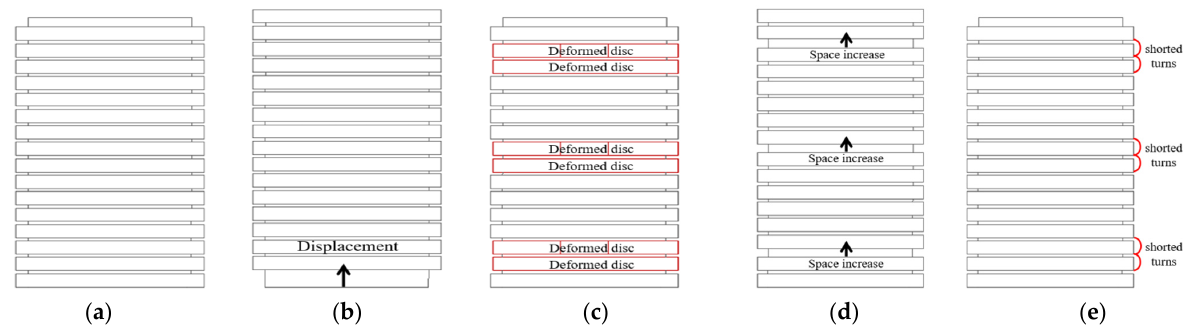
Figure 2. Laboratory winding model: ( a ) healthy state, ( b ) axial displacement, ( c ) radial deformation, ( d ) disc space variation and ( e ) shorted turns.